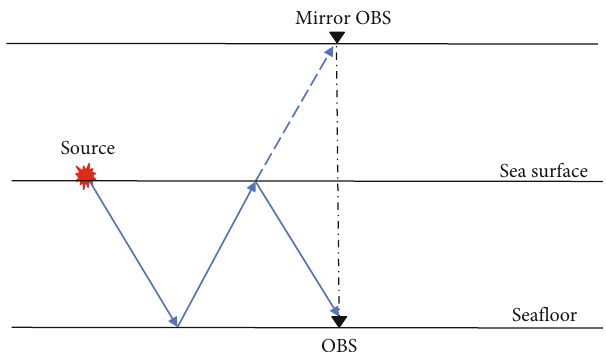
Figure 4: Schematic diagram of the mirror principle. For migration, multiple waves can be regarded as primary waves supposing that the OBS station is deployed on one surface above the sea fl oor, whose distance to the sea fl oor is twice the water column.